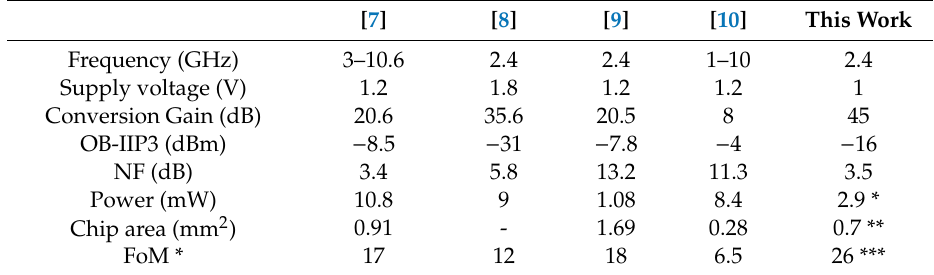
Table 2. Performance comparison of the proposed recursive mixer with other reported